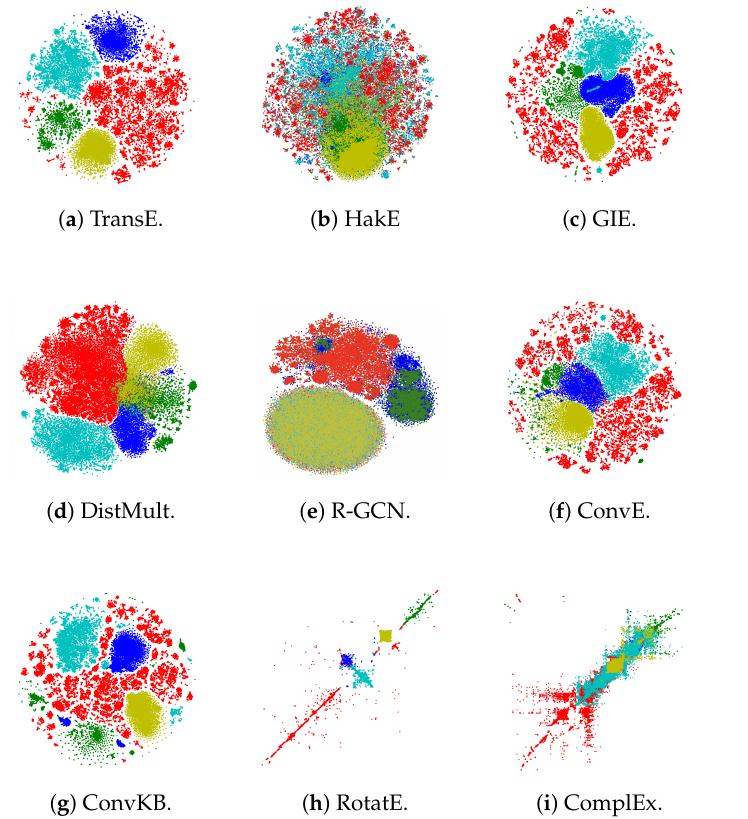
Figure 11. Entity embeddings compressed in 2D spaces using